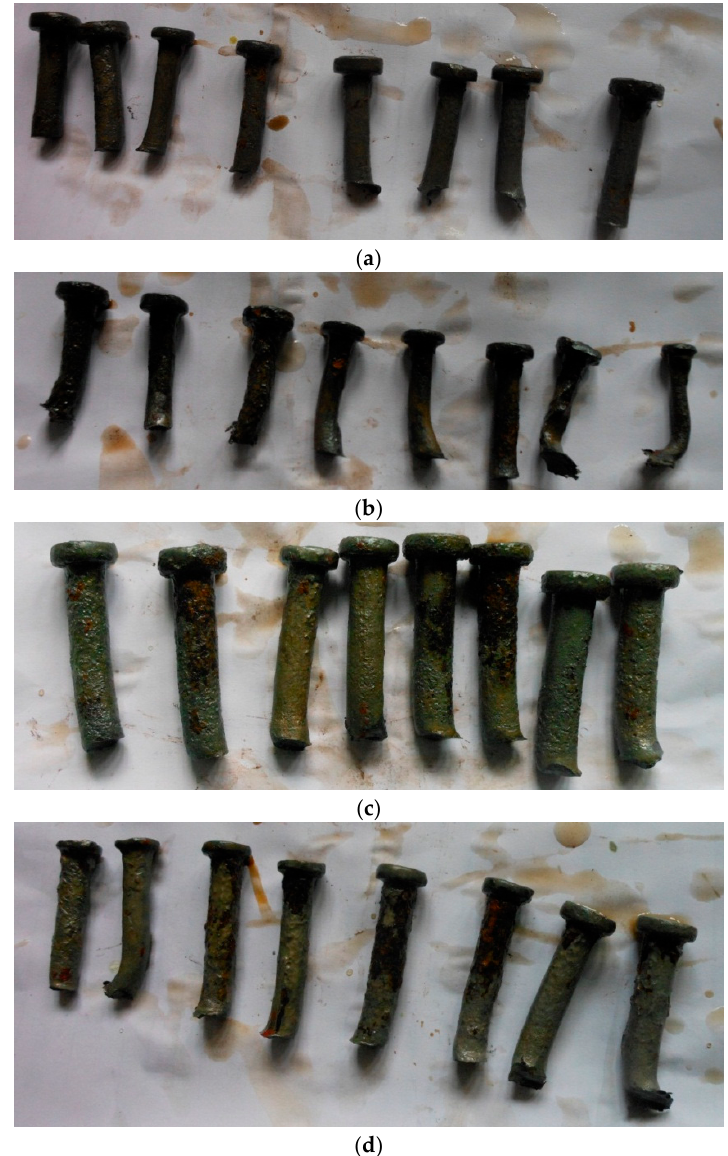
Figure 6. Corroded stud shear connectors: ( a ) 10–30; ( b ) 10–50; ( c ) 13–30; ( d ) 13–50.